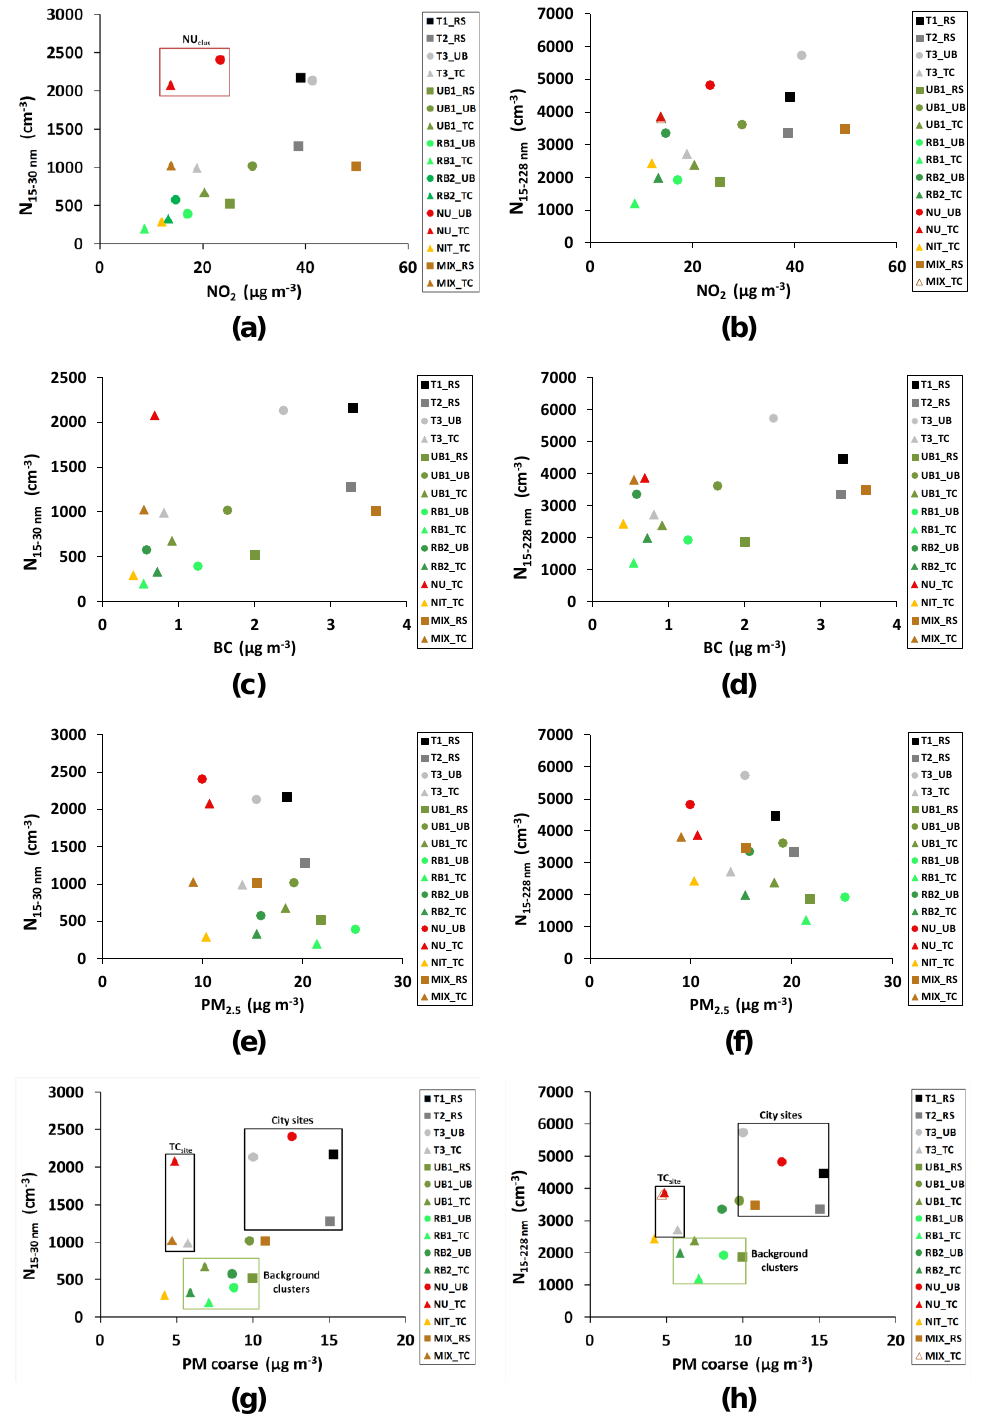
Fig. 4. Regressions of particle number concentration ( N ) against air quality parameters and other pollutants. The “Traffic” k -means cluster category at all monitoring sites is represented with grey-black dots, the “Background” k -means cluster category is coloured in green (light and dark) and the “Special cases” k -means cluster category in brown (light and dark): (a) N 15 − 30nm vs. NO 2 , (b) N 15 − 228 nm vs. NO 2 , (c) N 15 − 30 nm vs. BC, (d) N 15 − 228 nm vs. BC, (e) N 15 − 30 nm vs. PM 2 . 5 , (f) N 15 − 228 nm vs. PM 2 . 5 , (g) N 15 − 30nm vs. PM coarse , and (h) N 15 − 228nm vs. PM coarse . PM coarse refers to the fraction PM 10 –PM 2 . 5 . N concentrations are calculated from the SMPS